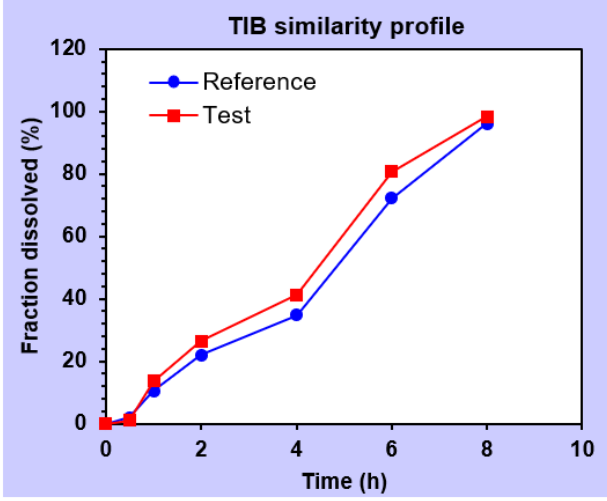
Figure 14. Diagram depicting the similarity profile of BZN before ( ) and after ( ) stability conditions.